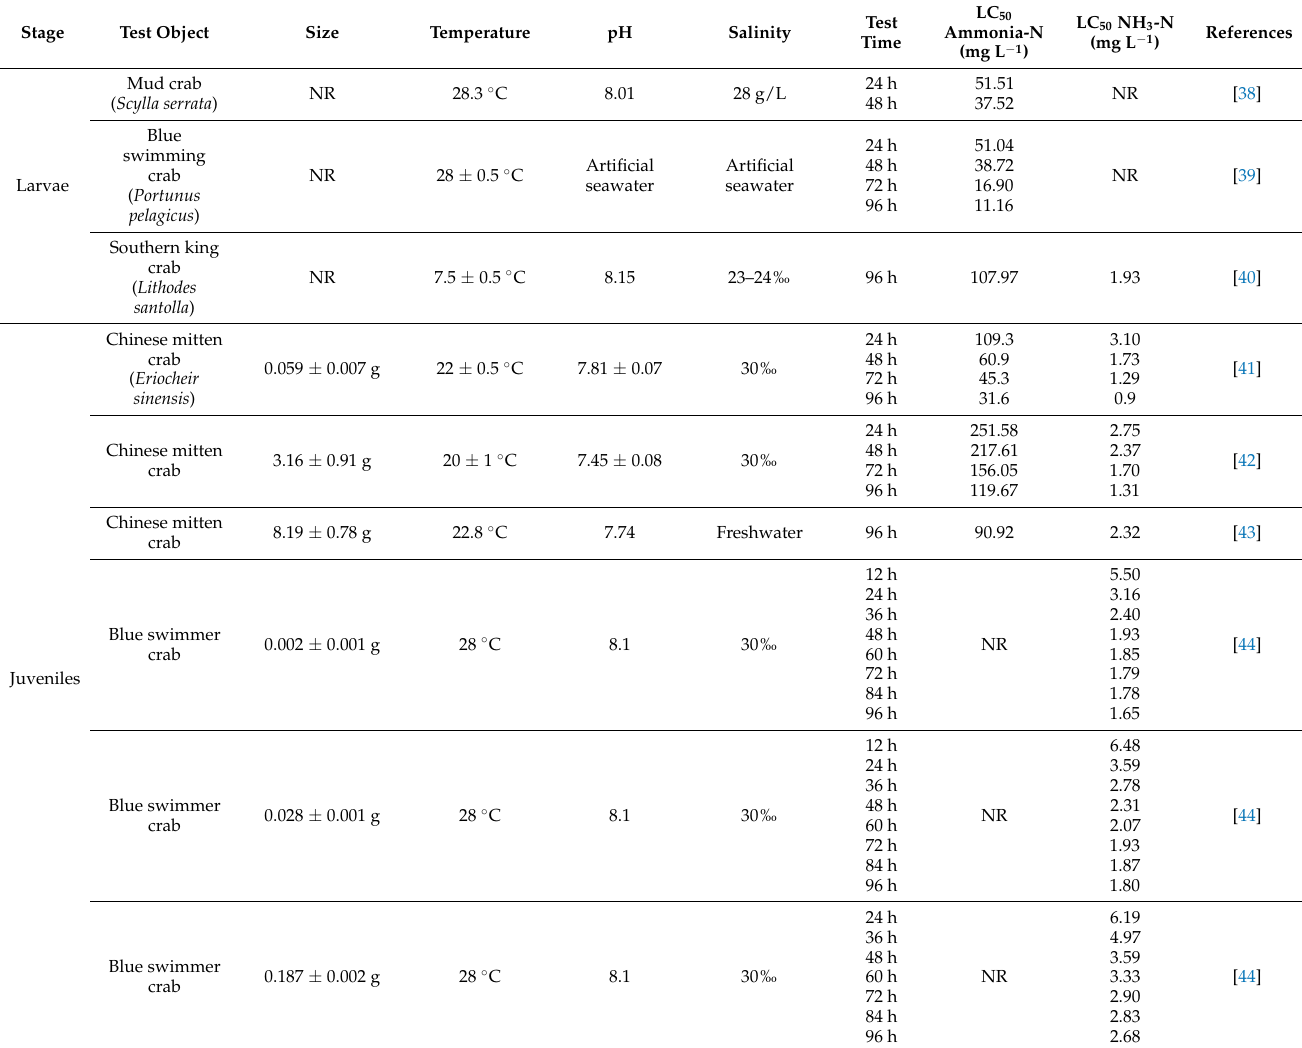
Table 2. Summary of acute toxicity of ammonia-N in